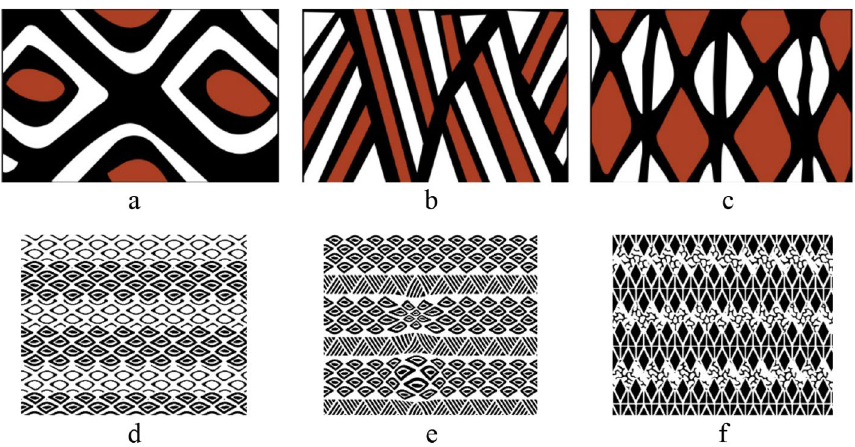
Fig. 5 a – c African design patterns in Sirigu wall paintings, and d – f Graphic patterns for designs 1–3 (Authors Own production)